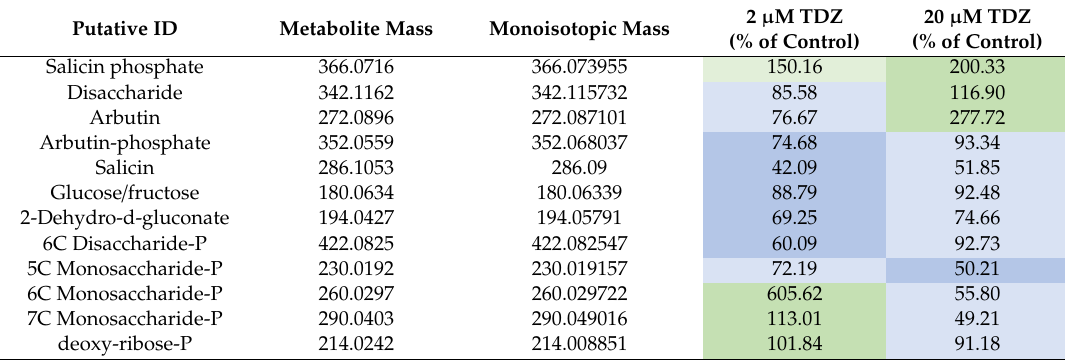
Table 6. E ff ect of thidiazuron treatment on sugar uptake and metabolism in petioles of African violet. Data are displayed as percent of control total ion count, where control is considered 100%. Coloring indicates increasing (green) or decreasing metabolites (blue) with highest decreases or increases in darker